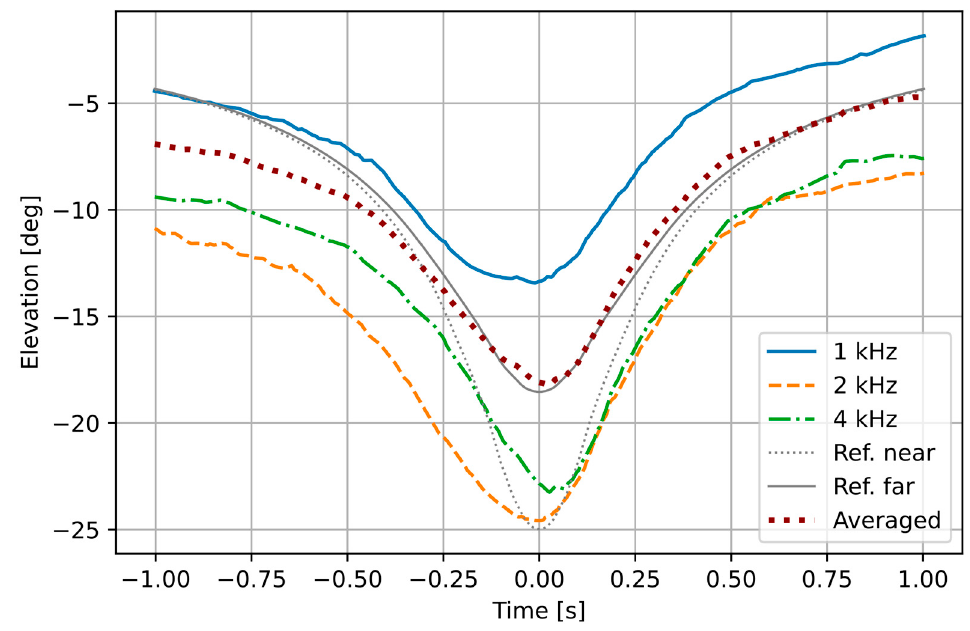
Figure 4. Elevation measured by the AVS and computed by the model.